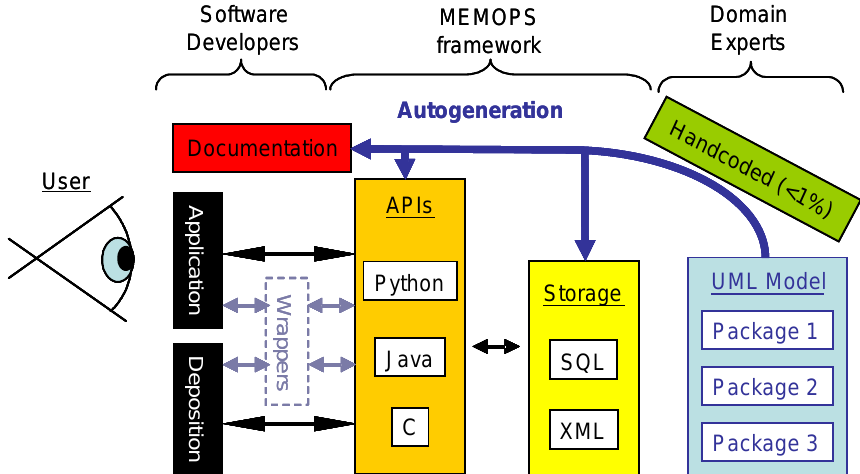
Figure 1: Organisation of the Memops framework. The data model, edited in UML [11 ] is split into packages, so that different domain experts can curate different areas, and so that applications can choose to work with only a subset of the model. Packages have one-way 'import' links to other packages that they depend on. XML and database schemas, persistence code, and the actual API implementations are generated automatically from the model. Over 99% of the final code is generated automatically. The remainder, including code for complex model constraints and non-standard functions, is added as language specific code snippets to the UML, so that the generated code is fully functional without manual modifications. Applications, written by third parties, ideally do all their data access by direct API calls.